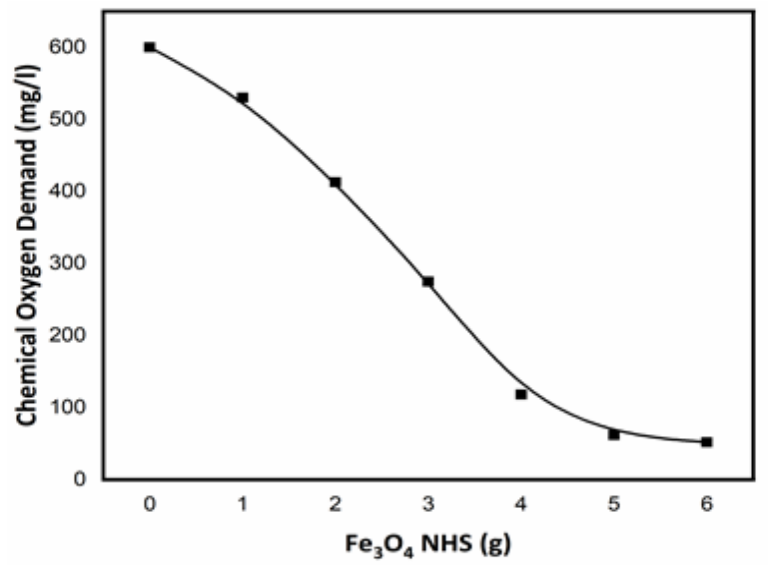
Figure 9. Effect of Fe 3 O 4 NHS concentration over COD reduction using MERK method at room tem- perature (25°C).